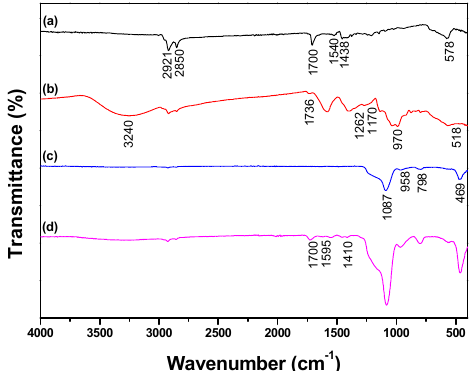
Figure 2. FT-IR spectra of nanospheres synthesized for the formation of fluorescent magnetic nanoparticles with a magnetic core/silica shell structure. ( a ) oleic acid (OA)-capped SPION, ( b ) SPION modified with phosphatidylcholine, ( c ) mSiO 2 @SPION and ( d ) Eu(TTA) 3 (P(Oct) 3 ) 3 @mSiO 2 @SPION.